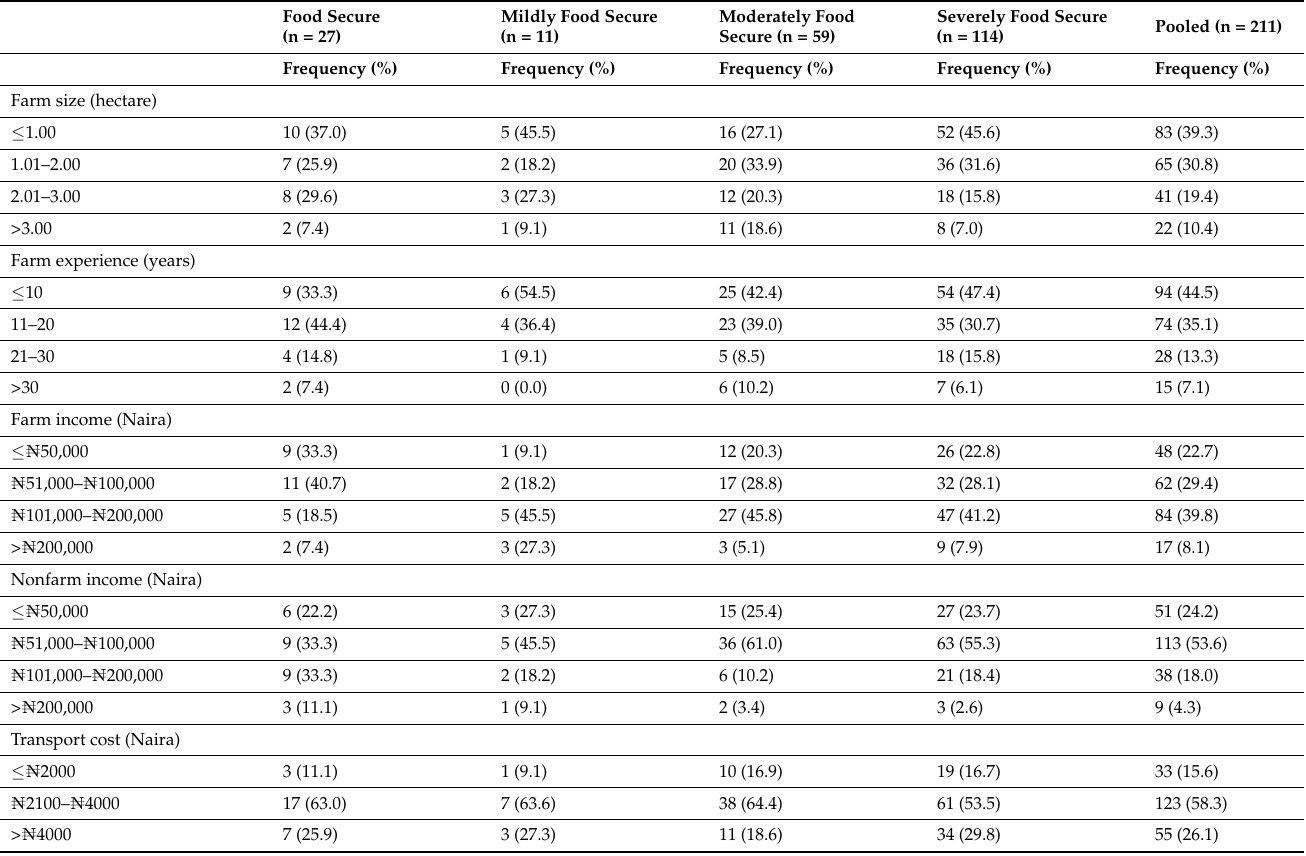
Nigeria are not connected to the national grid, leading to a higher percentage of households with no access to electricity. Table 7. Farm level distribution of households according to food insecurity category. Food Secure Mildly Food Secure Moderately Food Severely Food Secure (n = 27) (n = 11) Secure (n = 59) (n = 114) Pooled (n = 211) Frequency (%) Frequency (%) Frequency (%) Frequency (%) Frequency (%)